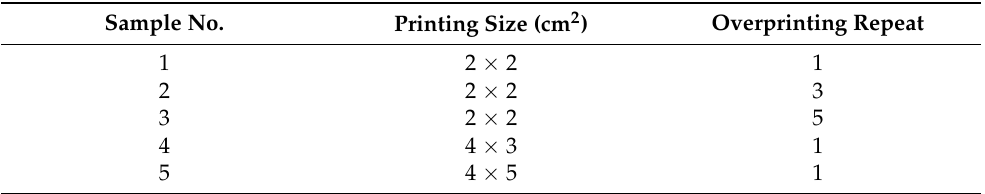
Table 1. Drug-loading evaluation of the orodispersible films with different printing sizes and overprinting